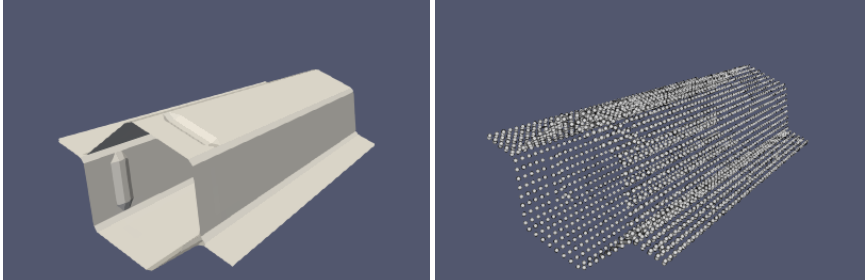
Figure 2. Reference surface ( left ) and nodes distribution on it ( right